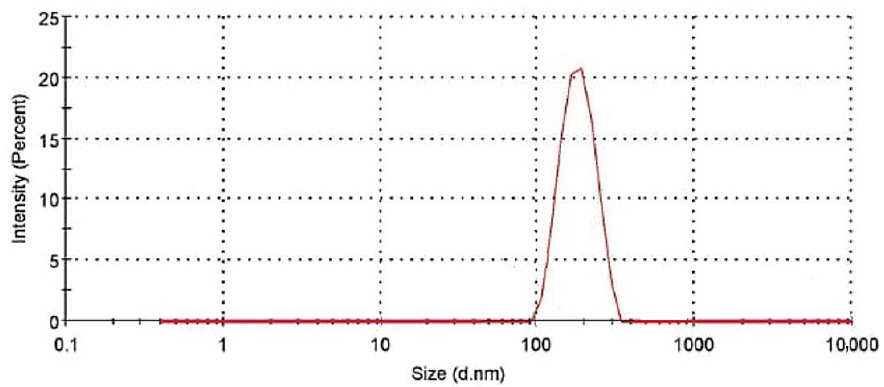
Figure 4. Particle size distribution of nanocellulose.